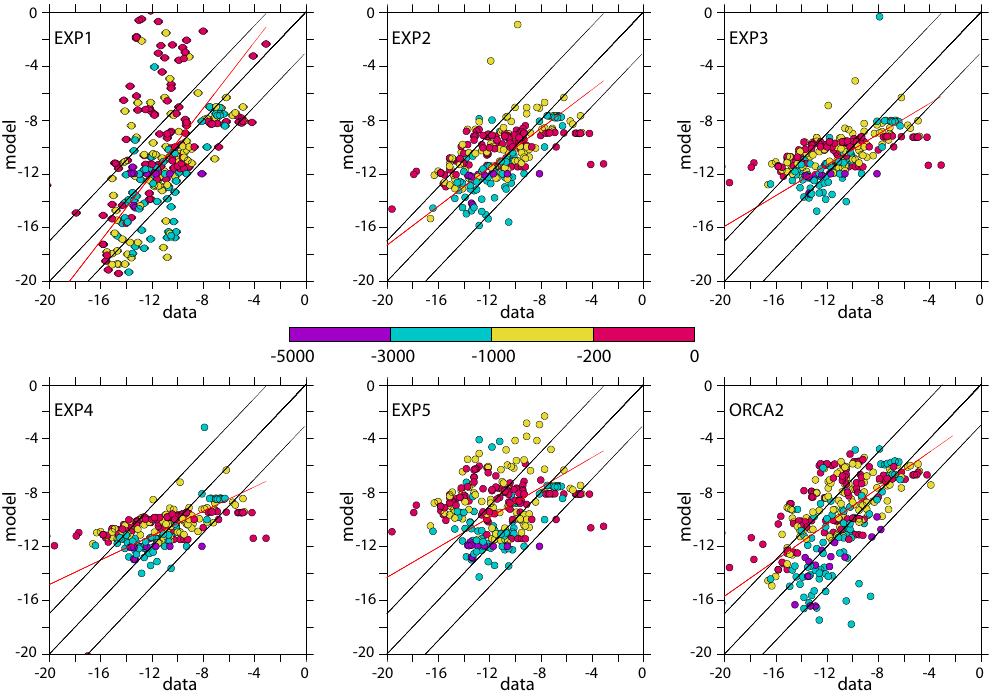
Fig. 1. Model/data comparison as a function of depth (color code) for the 5 simulations performed with the model in NATL4 configuration. The extraction in the North Atlantic from a previous simulation using the global ORCA2 configuration, with a relaxing time of 1 year, is also shown. Red line is the linear regression of the points. Diagonal black lines are lines ε Nd (modeled)= ε Nd (data), ε Nd (modeled)= ε Nd (data)+3 ε Nd and ε Nd (modeled)= ε Nd (data) − 3 ε Nd . In EXP5, relaxing time varies from τ =0.1 years for margins associated with a “high ε Nd ” value (=+8), to a relaxing time of τ =0.5 years for margins associated with a “low ε Nd ” value (= − 38). A linear relationship is set between those two extrema values. Main statistical characteristics for each experiment are reported in Table